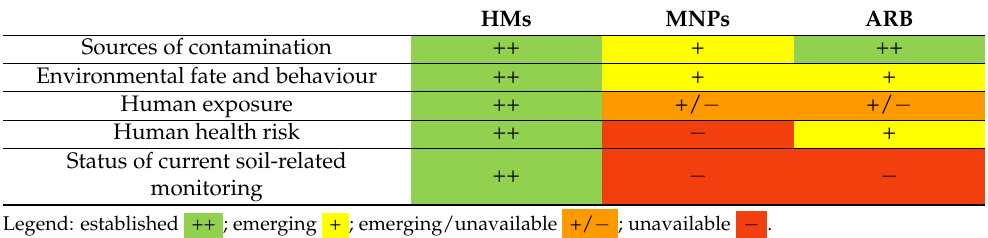
Table 3. Available knowledge relevant for human health risk assessment of soil-related